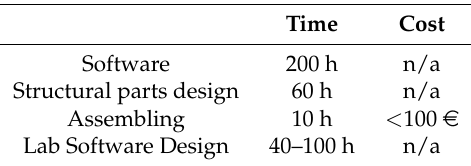
Table 2. Cost and time